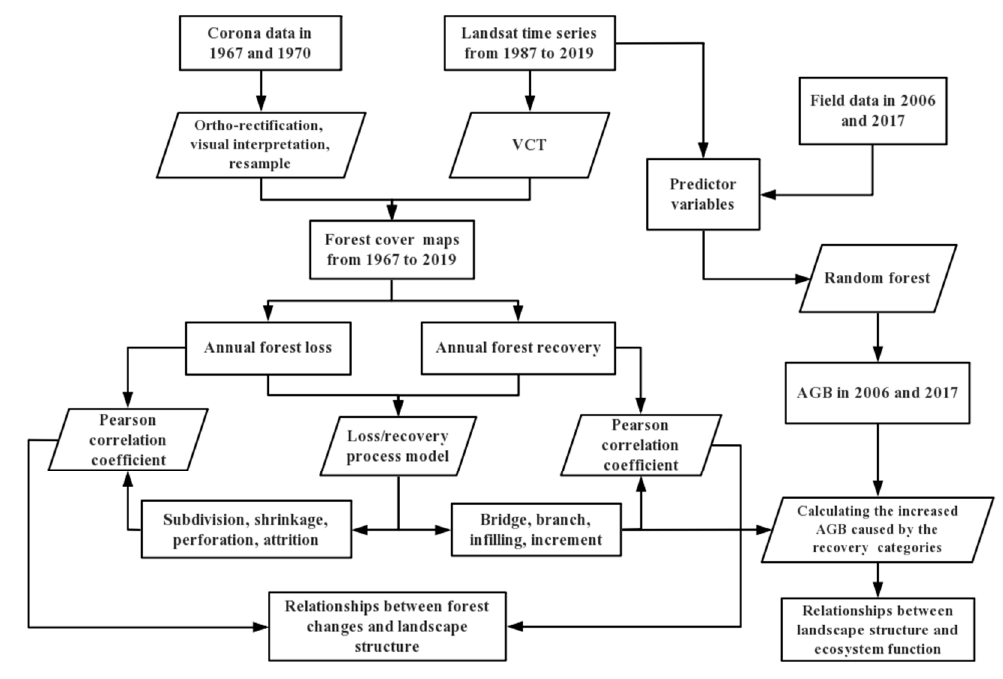
Figure 2. Workflow diagram of the current analysis.